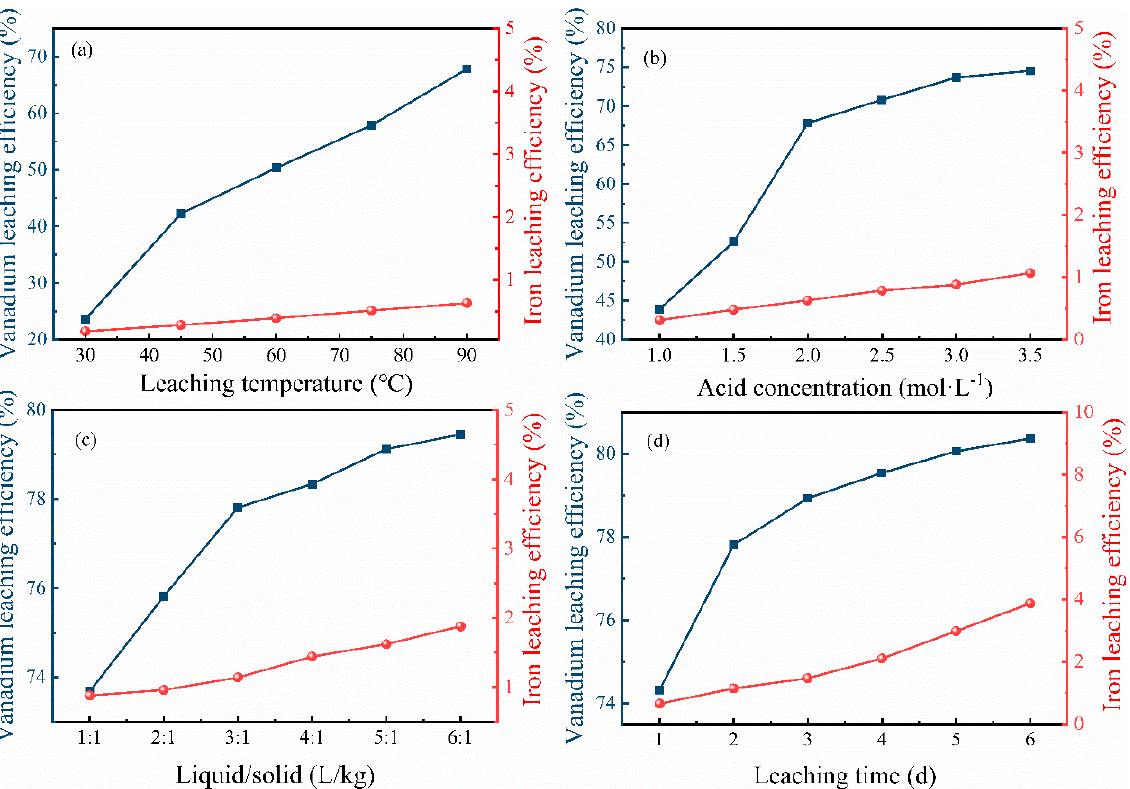
Figure 7. Effect of acid leaching factors on the leaching rate of vanadium and iron from pellets. ( a ) Effect of leaching temperature; ( b ) Effect of acid concentration; ( c ) Effect of liquid-solid ratio; ( d ) Effect of leaching time.